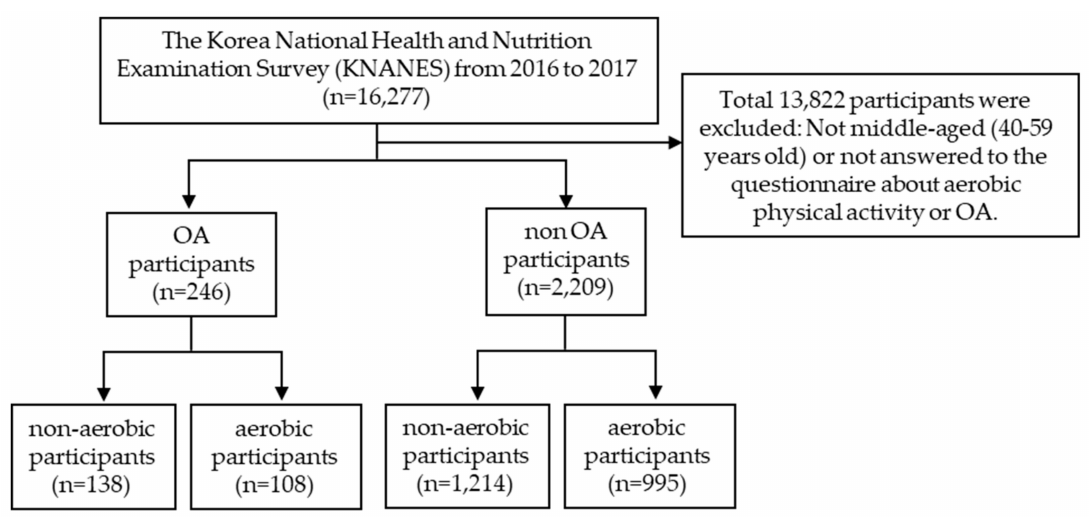
Figure 1. Flowchart describing the selection criteria for the